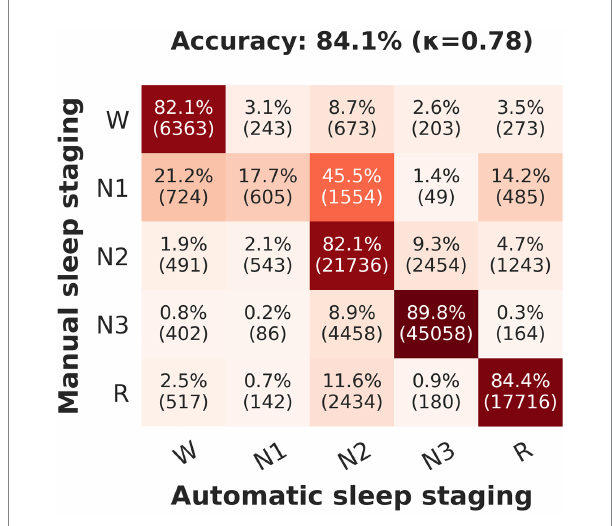
FIGURE 3 Confusion matrix of the test set classification performance aggregated across all 10 folds of the cross-validation in the primary analysis set ( n = 105, total number of epochs = 108,796). Each row of the matrix represents the instances in the manual reference scoring while each column represents the instances in the neural network- predicted sleep scoring. The diagonal of the matrix shows all correct predictions. Values presented inside parentheses denote the number of epochs in each predicted class. W, Wakefulness; R, Rapid eye movement sleep; N1, N2, N3, Three different levels of non-rapid eye movement sleep; κ , Cohen’s kappa coefficient.